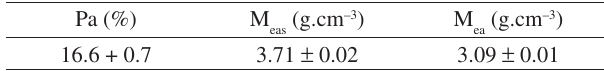
Table 3. Physical properties of the material under study.